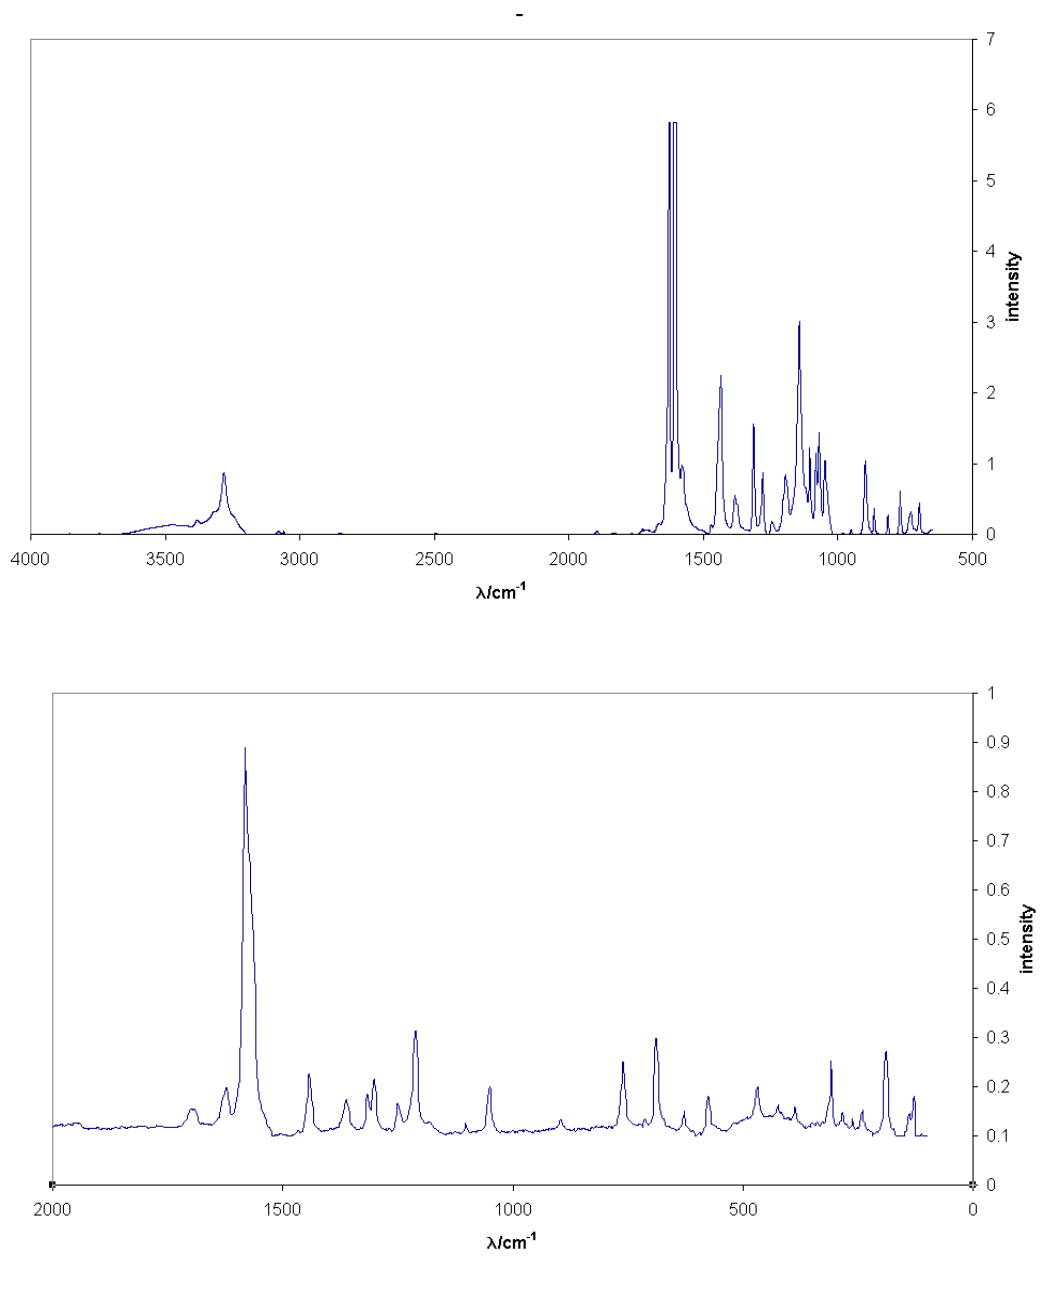
Figure 5. IR (above) and FT-Raman (below) spectra of 6,6’-dibromoindigo